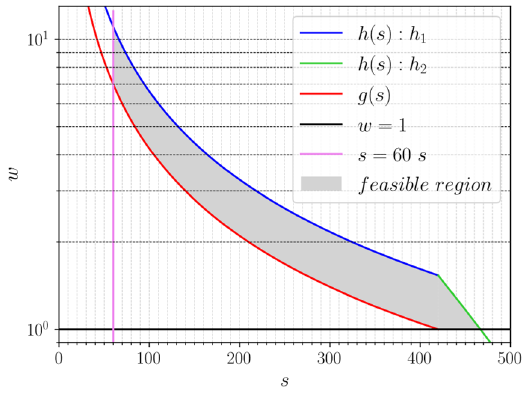
Figure 3. Constraints for AoI α = 420 s, α = 0.9, λ = 1/1800 s − 1 and s min = 60 s (log scale on the y-axis).